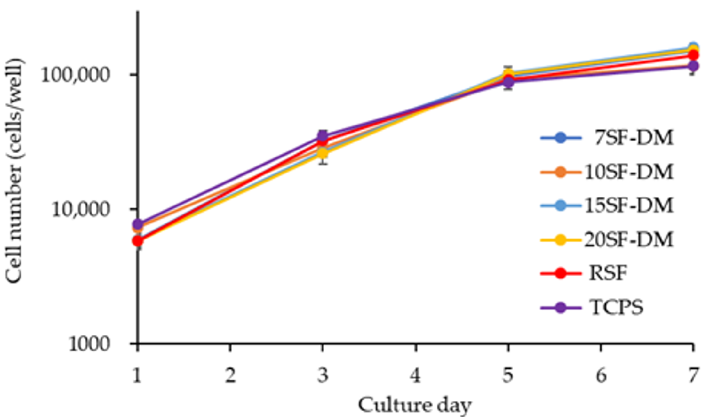
Figure 4. NIH3T3 cell proliferation on the coating film of the fractionated SFs and TCPS. The cell number is shown on a logarithmic